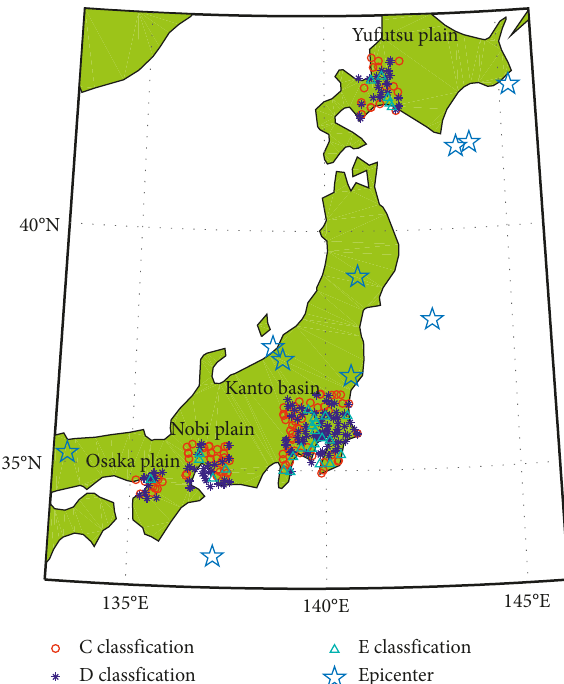
Figure 4: The map shows that stations belonging to K-NET and KiK-net strong networks, Japan, are distributed across Osaka plain, Nobi plain, Kanto basin, and Yufutsu plain, respectively, wherein geological conditions are likely to generate long-period motions; in terms of site classifications referring to the National Earthquake Hazard Reduction Program (NEHRP) standards, the stations are marked with circles, stars, and triangles to represent C, D, and E site classifications, respectively; pentagons represent the epicenter of each